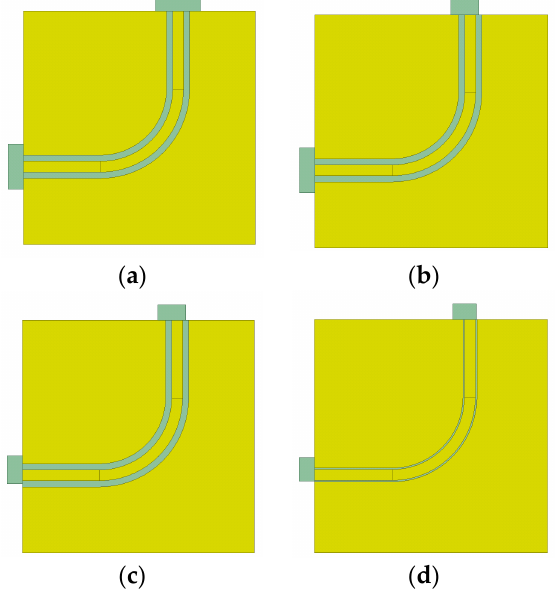
Figure 4. Models for electromagnetic simulation of thru with different types of probes, while ( a ) represents GSG ‐ GSG model; ( b ) represents SG ‐ GSG model; ( c ) represents initial SG ‐ GS model; ( d ) represents improved SG ‐ GS model.